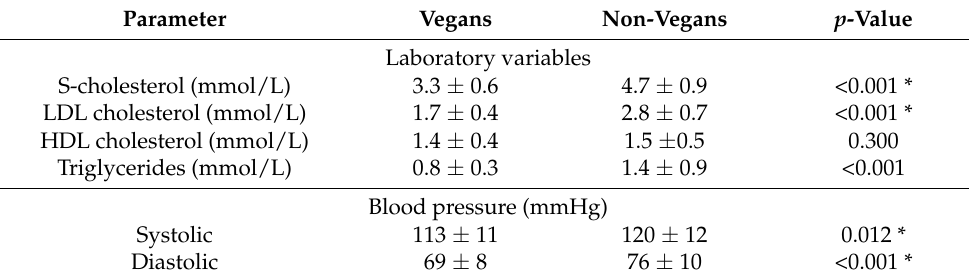
Table 4. Cardiovascular health